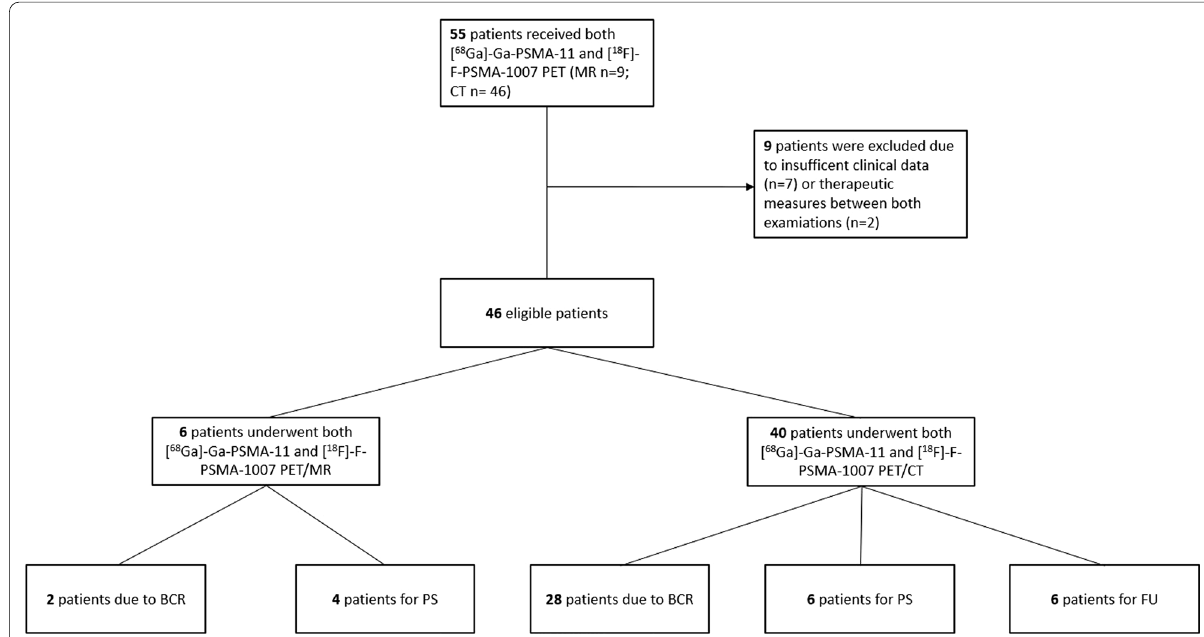
Fig. 1 Patients who received both [ 18 F]-F-PSMA-1007 and [ 68 Ga]-Ga-PSMA-11 by indication and device. BCR: Biochemical recurrence; PS: primary staging; FU: follow-up of pre-known